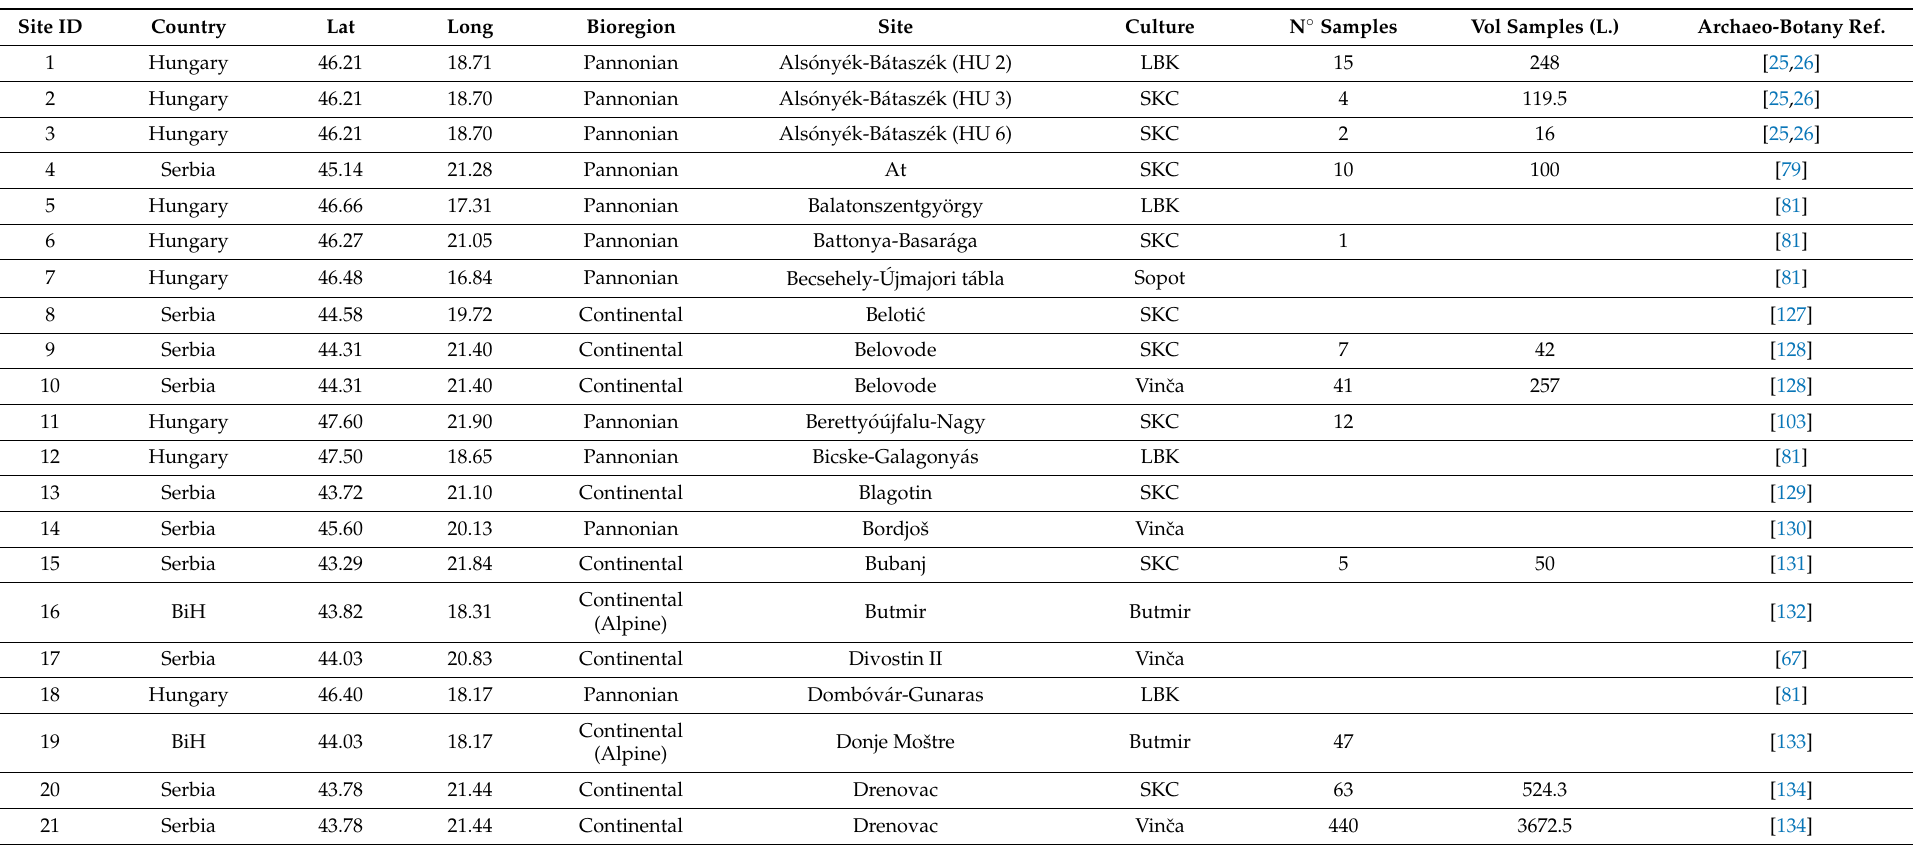
Table A1. Sites included in the multivariate statistical analyses. Site ID refers to Figure 1. The complete archaeobotanical dataset can be found in the Supplementary Materials, Table